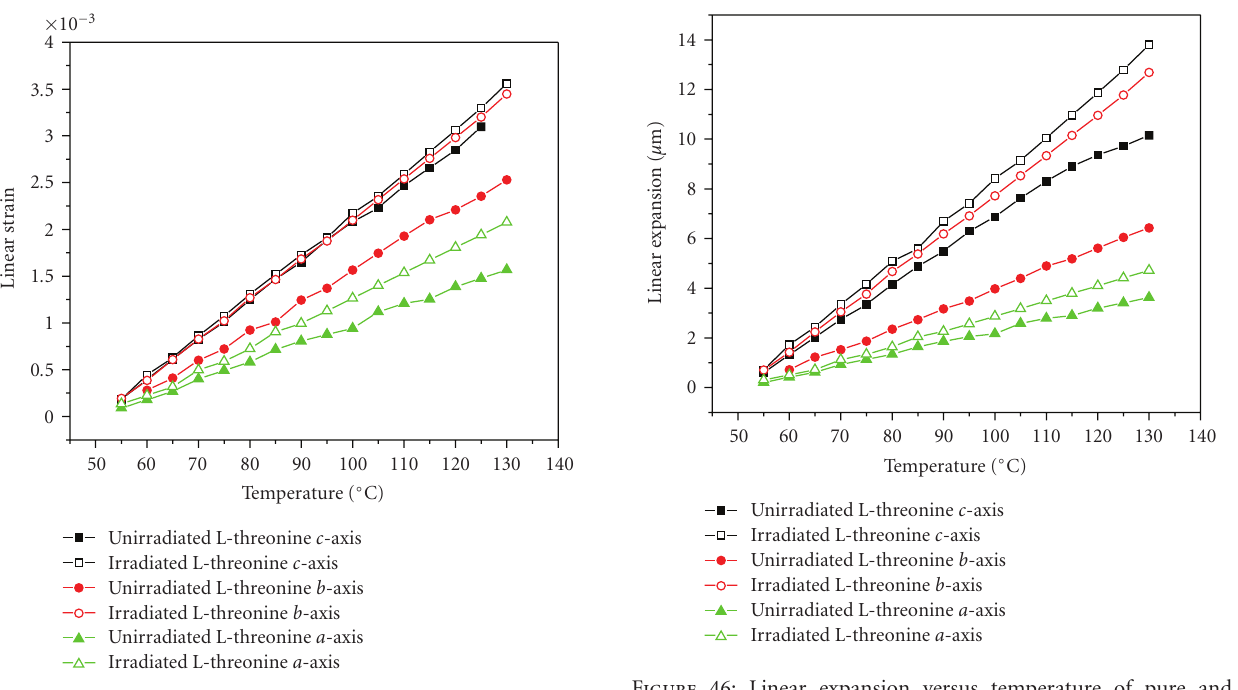
Figure 45: Linear strain versus temperature of pure and electron- irradiated L-threonine crystal at 12 × 10 14 e/cm 2 .